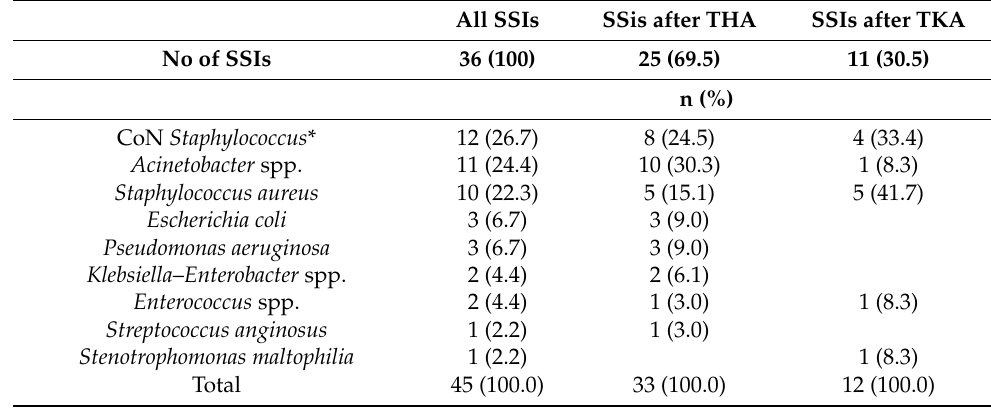
Table 3. Microorganisms causing